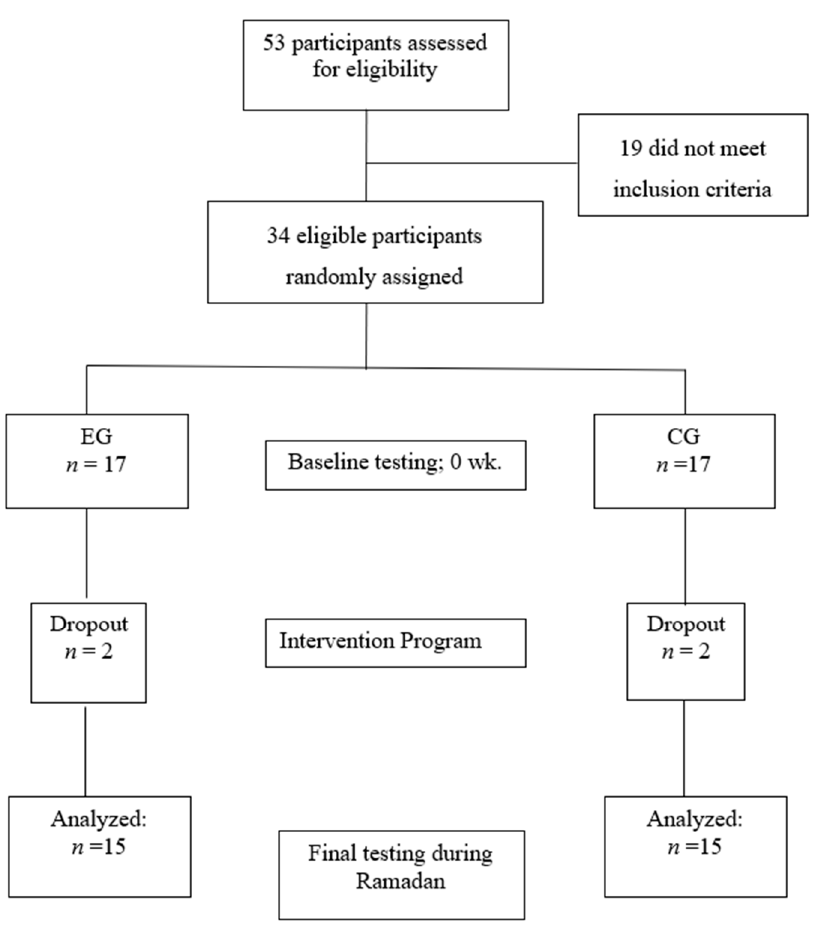
Figure 1. Participant recruitment and allocation to study groups.